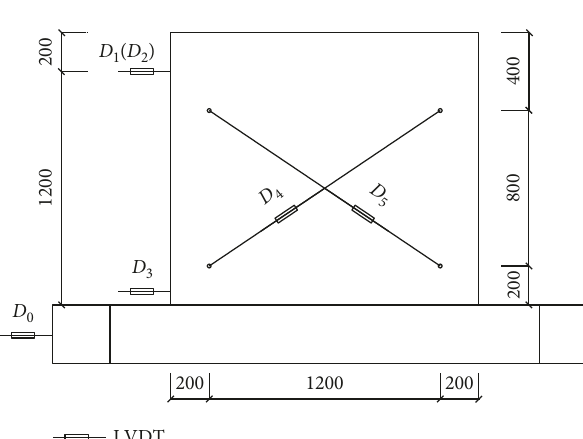
Figure 5: Measurement layout of